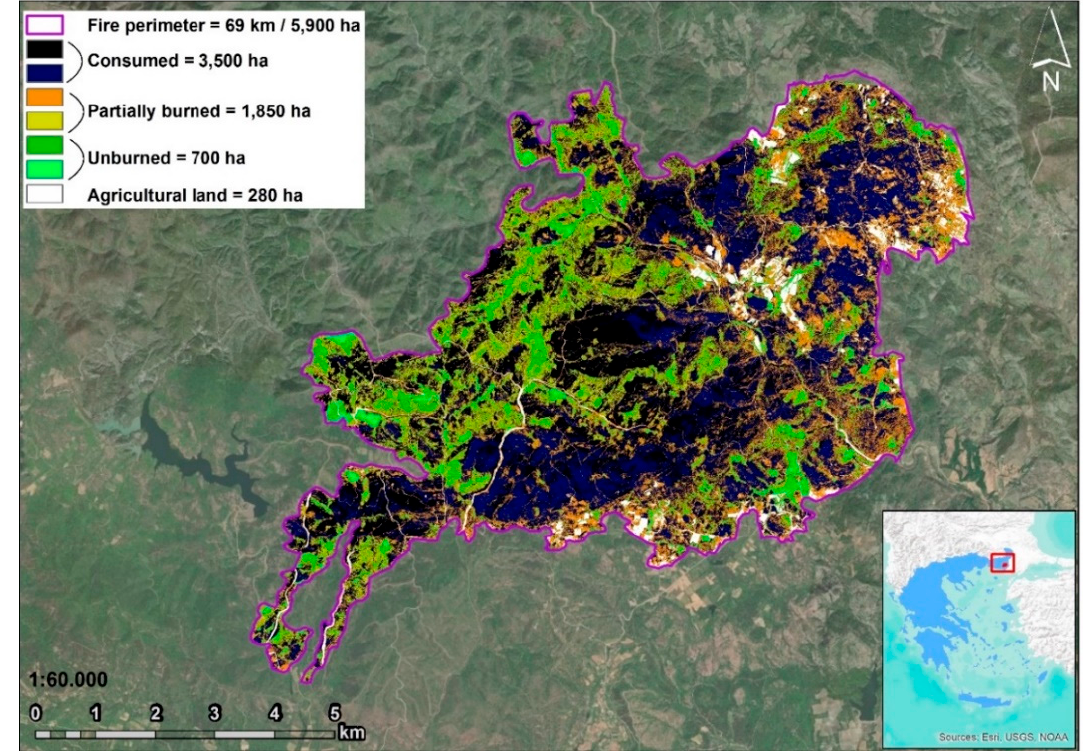
Figure 3. The August 2011 Evros fire in northern Greece, with the di ff erent burn e ff ects on vegetation highlighted with di ff erent colors. Black: consumed; orange: scorched or partially burned; green: